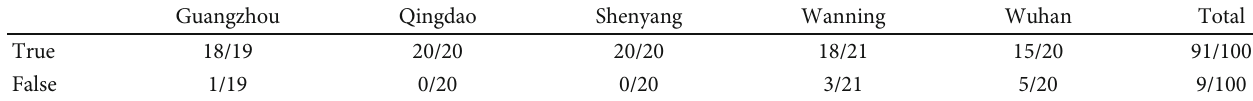
Table 8: Classi fi cation accuracy of the experimental region in various well data-accumulated areas.